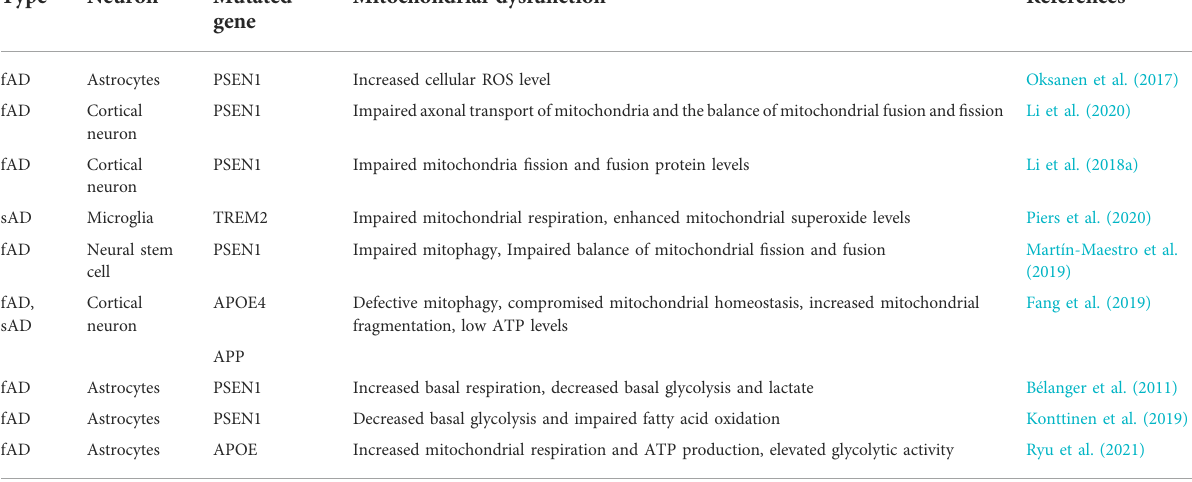
TABLE 2 Mitochondrial dysfunction in iPSC-derived neurons and astrocytes modeling of AD.